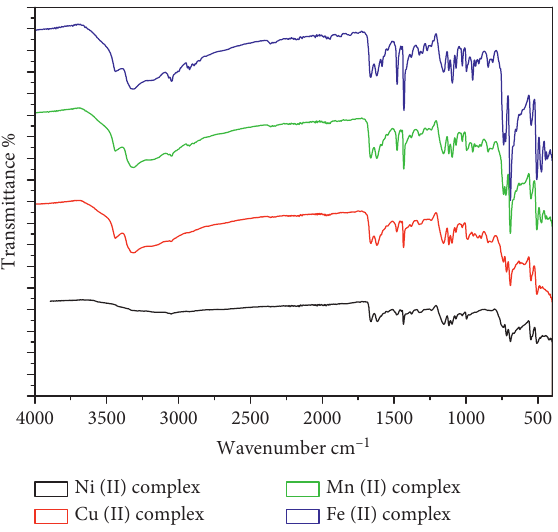
Figure 2: FT-IR spectra of Ni(II), Cu(II), Mn(II), and Fe(II) complexes.